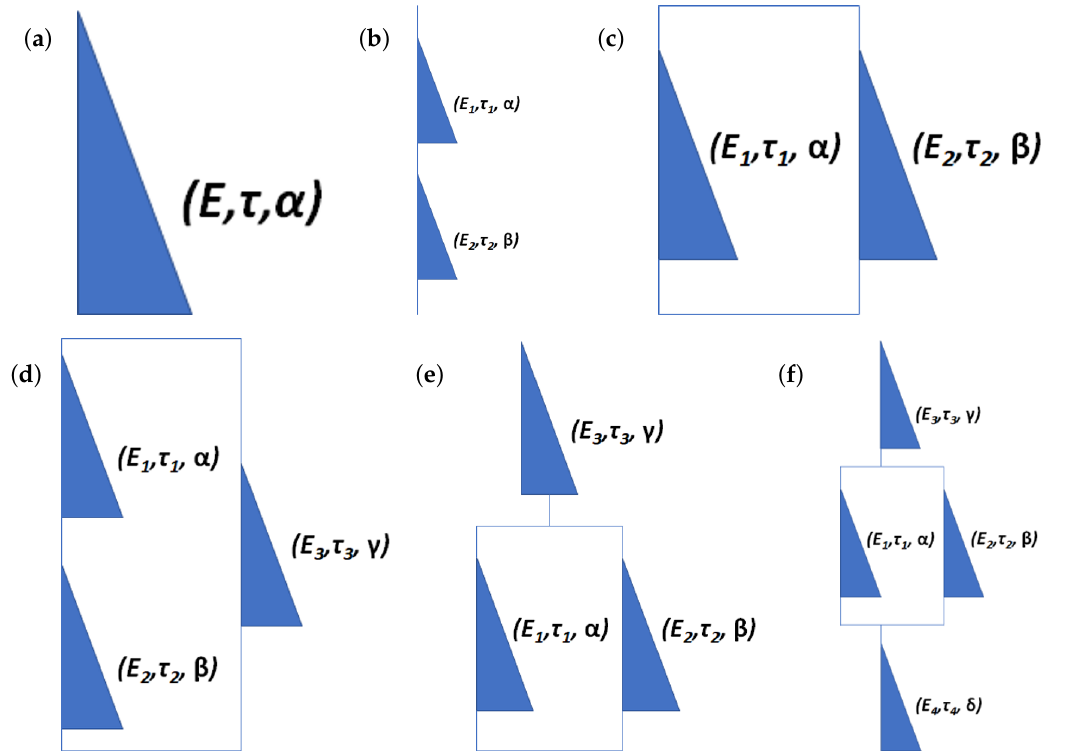
Figure 2. Fractionalmodels: ( a )basicelement; ( b )Maxwell; ( c )Kelvin–Voigt; ( d )Zener; ( e )Poynting–Thomson; ( f )